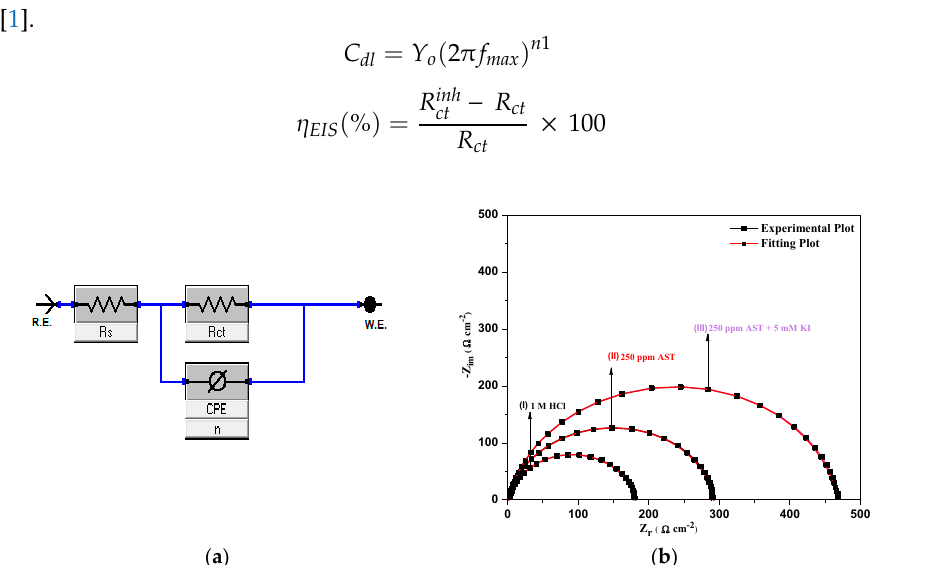
Figure 7. ( a ) Equivalent circuit model used to fit the EIS data for C1018 carbon steel in 1 M HCl solution and ( b ) corresponding fitting plots. Table 4. Electrochemical kinetic parameters obtained from EIS data for C1018 carbon steel in 1 M HCl and various concentrations of AST and AST + KI at 25 °C.